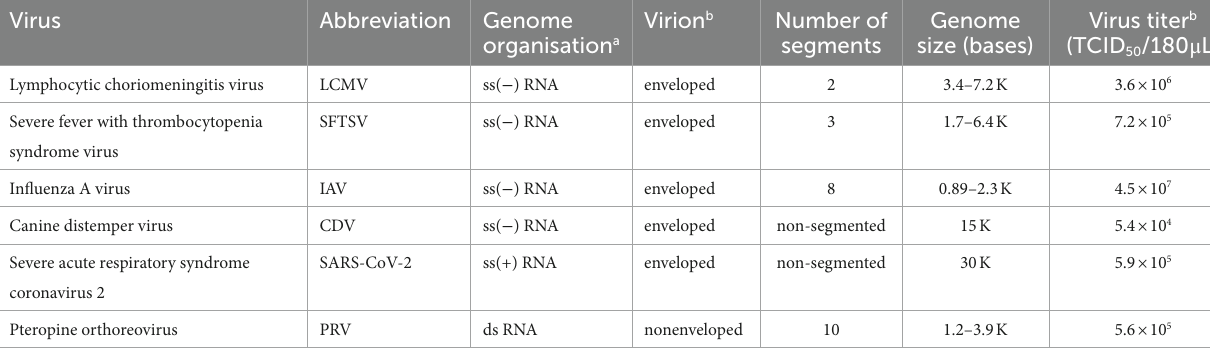
TABLE 2 RNA viruses used in this